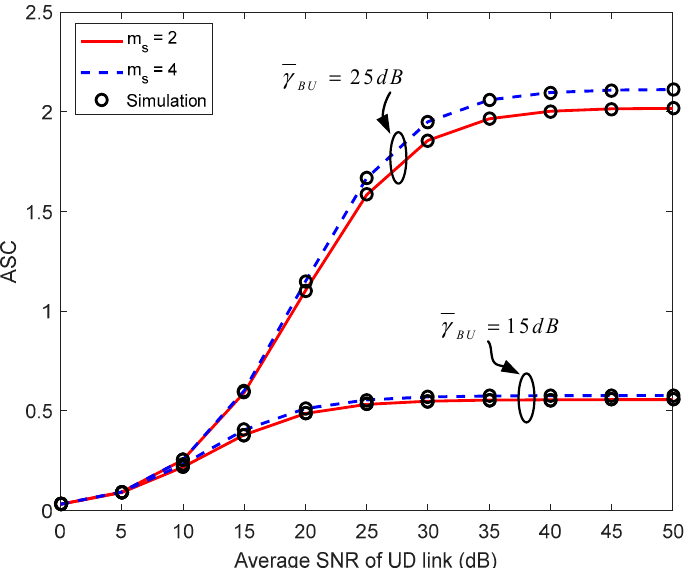
Figure 8. ASC performance under different values of m s and γ UE when ρ e = 3 × 10 − 6 , γ BU = 15 dB, and h u = 5 𝑘𝑚 .